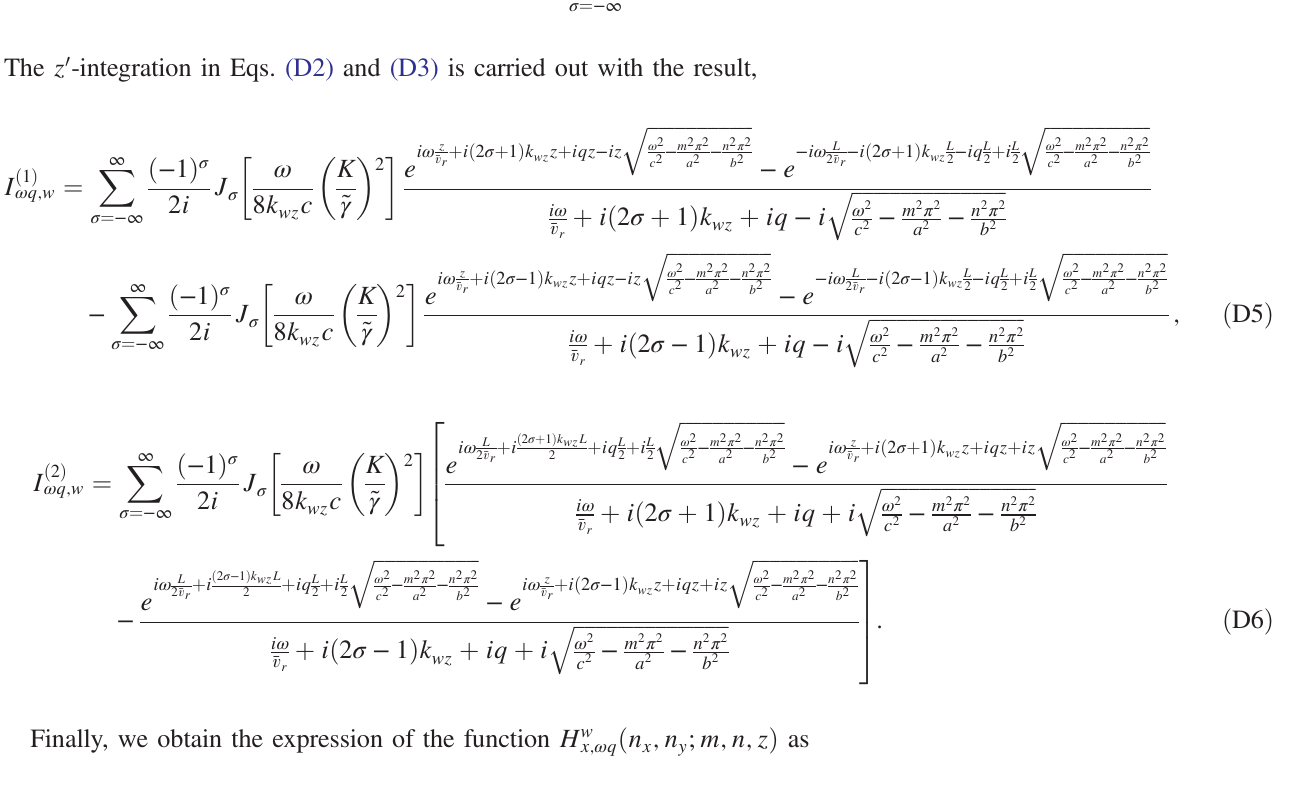
ffiffiffiffiffiffiffiffiffiffiffiffiffiffiffiffiffiffiffiffi